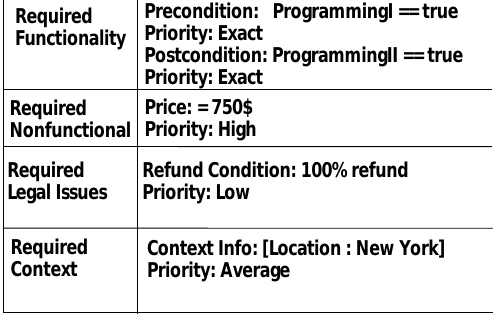
Figure 8. Informal Course